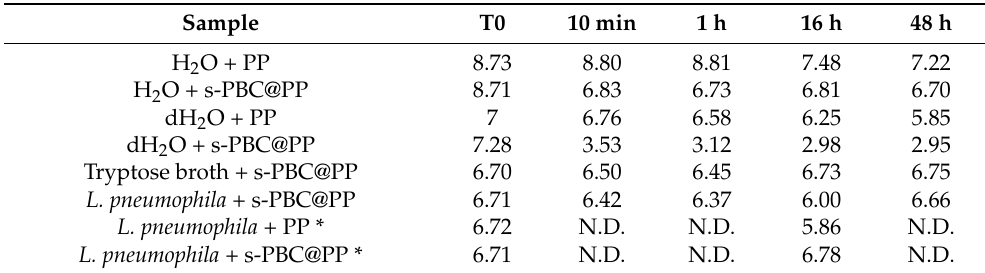
Table 1. pH analysis of various media involved in the biofilm formation experiment after exposure to floating coupons.